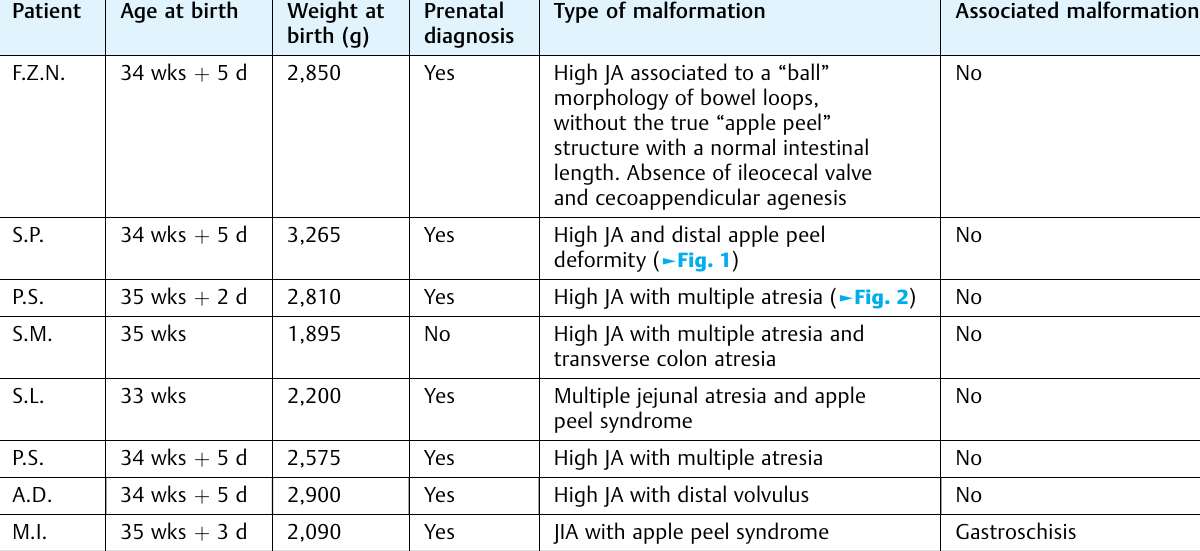
Table 1 Data of